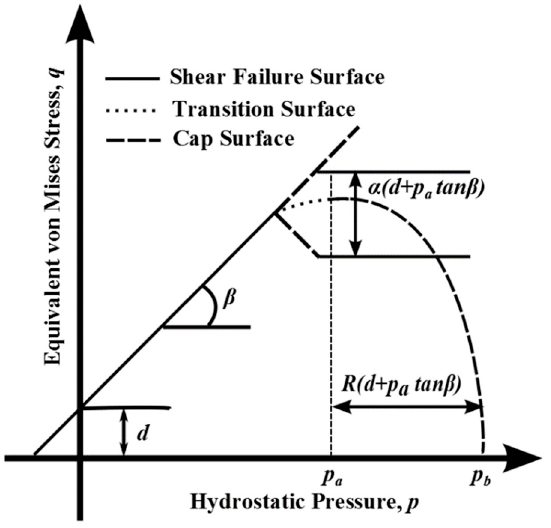
Figure 1. Drucker–Prager Cap yield surface in meridian plane.